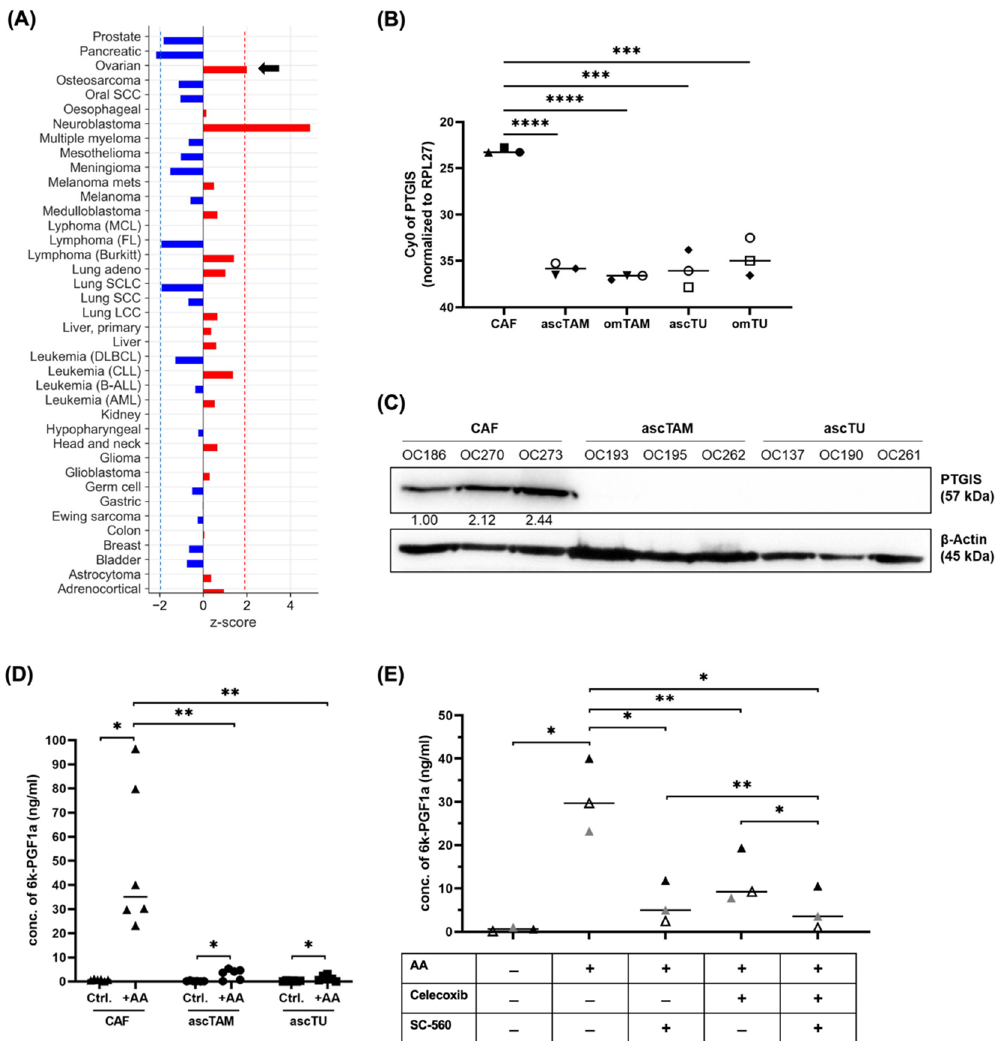
Figure 2. Validation of cell-type-selective PTGIS expression and PGI 2 synthesis. ( A ) Association of PTGIS expression with overall survival (OS) for different cancer entities based on the PRECOG database [34]. Red: positive z-scores (hazard ratio > 1); blue: negative z-scores (hazard ratio < 1). A z-score of |1.96| equals a p value of 0.05. Significance thresholds are indicated by dashed blue and red lines. ( B ) RT-qPCR analysis of PTGIS mRNA expression in CAF, TAM (ascTAM, omTAM) and tumor cells (ascTU, omTU) from n = 3 different patients (patients are distinguished by different symbols). *** p < 0.001; **** p < 0.0001 by unpaired t test. ( C ) Detection of PTGIS protein in CAF, ascTAM and ascTU by immunoblot (n = 3; patient; OC…: patient identifiers). β -actin was used as loading control. ( D ) MS-based quantification of 6k-PGF 1 α (stable degradation product of PGI 2 ) in conditioned media (CM) from CAF, ascTAM, and ascTU after serum deprivation in the presence of 50 µM AA for 24 h. Controls without AA are included for each cell type. * p < 0.05; ** p < 0.01 by unpaired t test (Comparison of different cell types) and paired t test (Ctrl vs. AA-treated cells). ( E ) Effect of COX1/2 inhibitors on PGI 2 biosynthesis by CAF. Concentrations of 6k-PGF 1 α were measured by MS in CM of CAF under serum-free conditions in the presence of 50 µM AA and either 1 µ M COX1 inhibitor SC-560 and/or 10 µ M COX2 inhibitor celecoxib for 24 h. * p < 0.05; ** p < 0.01 by paired t test. Horizontal bars show the